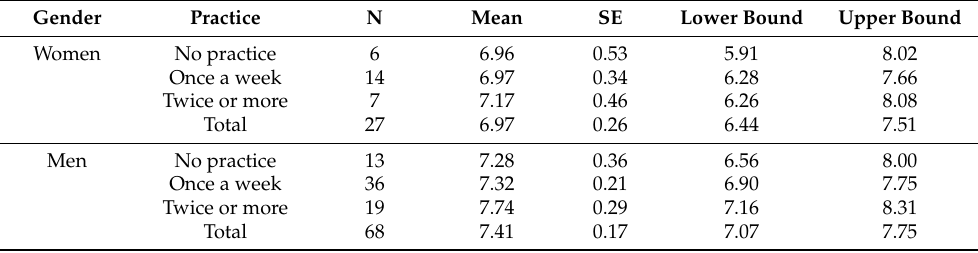
Table 3. Means and 95% confidence intervals for female and male goalkeeper responses on perceived- ability questions (10-point Likert scale) divided by the amount of practice of empty-goal scenarios. Gender Practice N Mean SE Lower Bound Upper